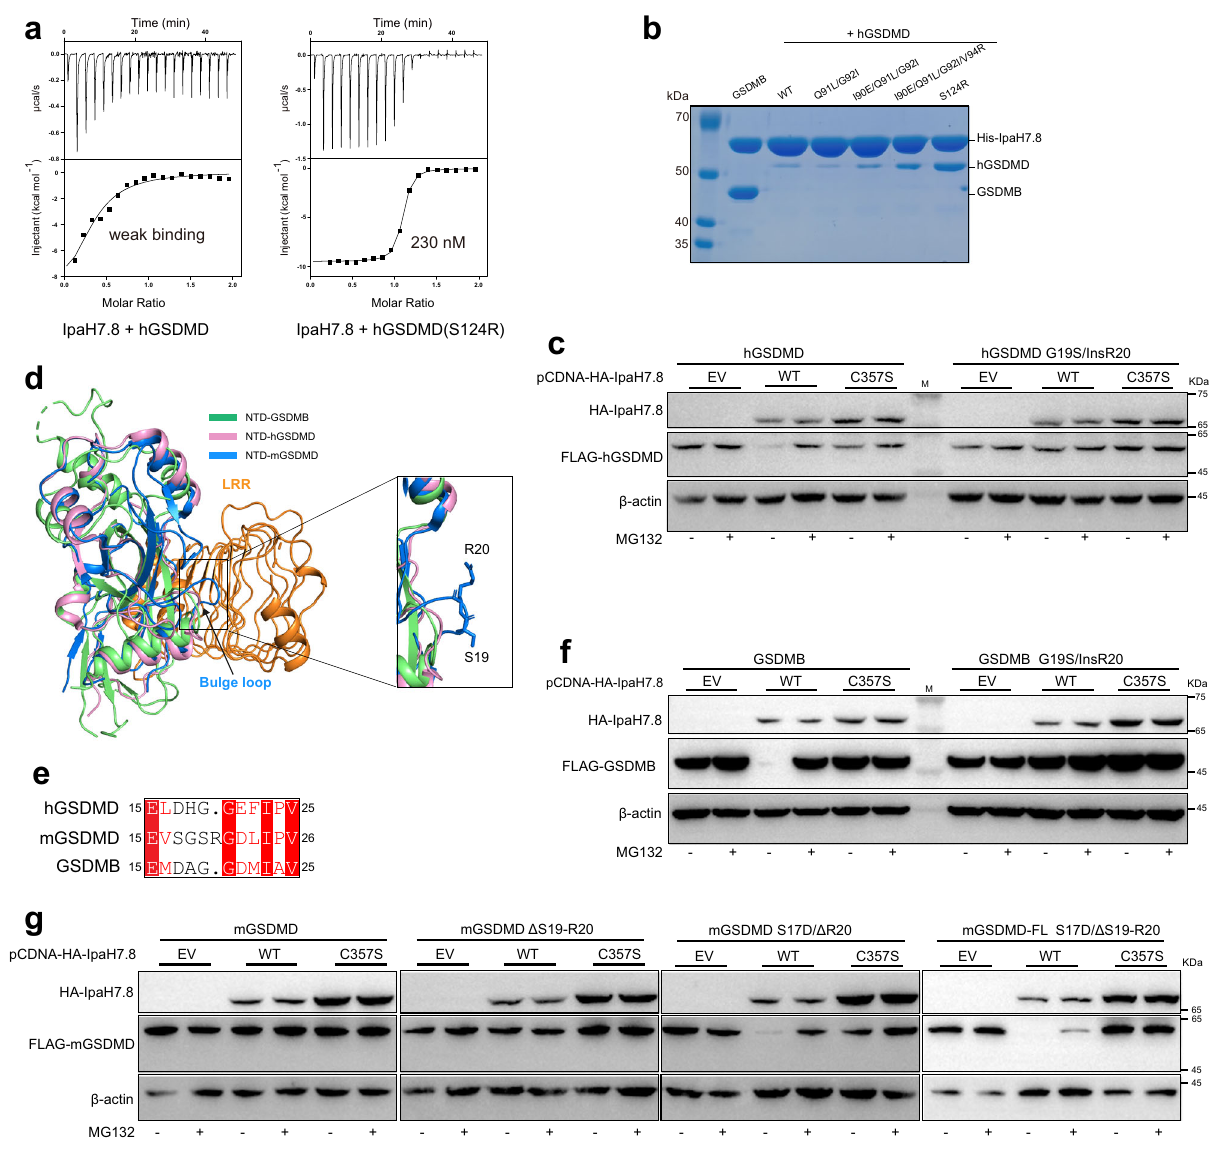
Fig. 6 | Biochemical and functional characterization of the interactions between GSDMD and IpaH7.8. a Quanti fi cation of the binding af fi nity between human GSDMD (hGSDMD) and IpaH7.8 by ITC. b In vitro pull-down of WT or mutant hGSDMD proteins by His-tagged IpaH7.8. c IpaH7.8 triggered the hGDSMD degradation.Cellulardegradation assaysin cells expressing the IpaH7.8 and hGSDMD proteins indicated. C357S, IpaH7.8 catalytic dead mutant. insR20, insertion of an additional arginine after the 19th residue. Cells were treated with or without MG132. d Structural alignments of NTD-GSDMB with human and